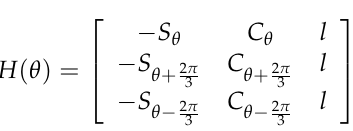
Figure 2. Coordinate system of an omnidirectional mobile robot By using singleton fuzzifier, product inference, center-average defuzzifier, and Gaus- 88 sian membership function, the output of the FLS can be expressed as linear combinations 89